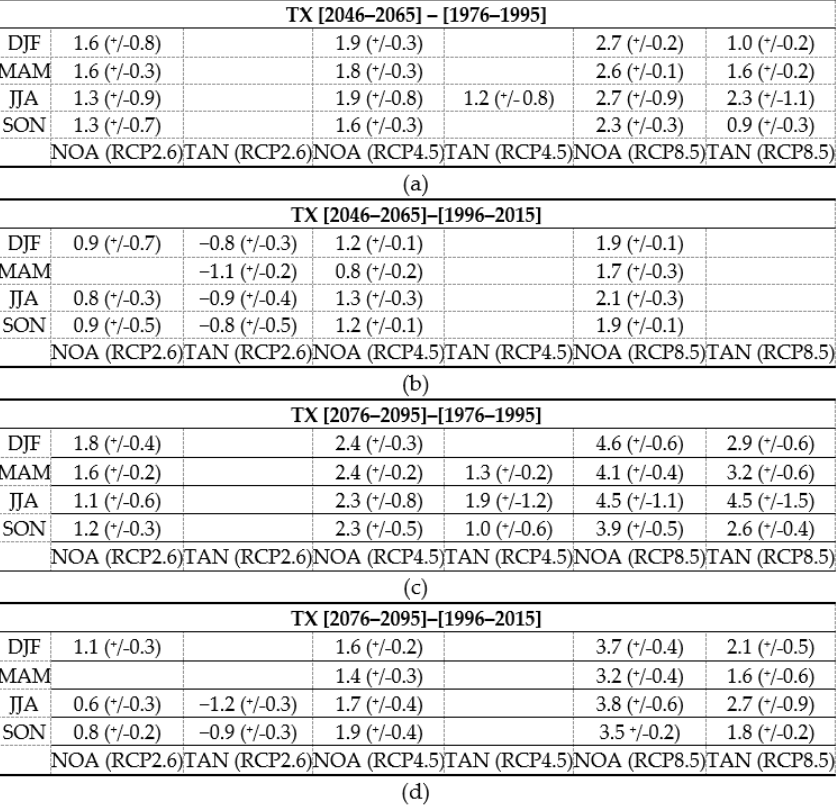
Figure 5. ( a – d ): Statistically significant changes in future seasonal maximum temperatures, compared to the respective reference periods (see Figure 2), at the sites of NOA (urban) and TAN (rural). Values represent the mean change with the respective confidence range. Squares left blank indicate no statistically significant difference. The near and distant future periods (2046–2065 and 2076–2095) have each been compared to the first and second reference periods (1976–1995 and 1996–2015).